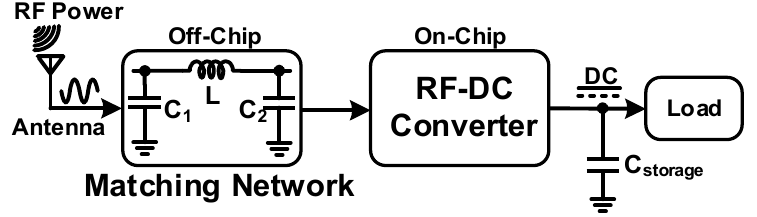
Figure 1. Block diagram of an RF energy harvester.